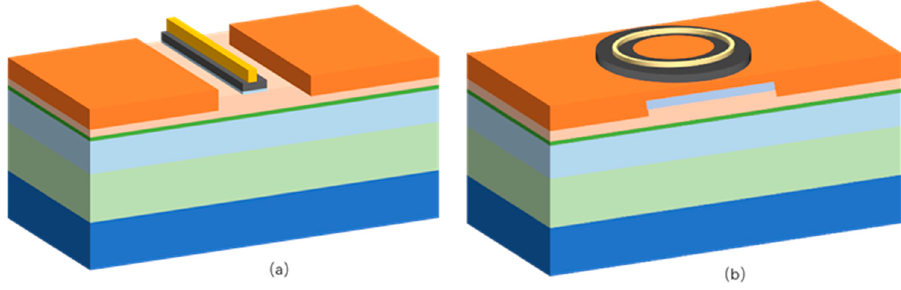
Figure 2. ( a ) 3D image of conventional HEMT device and ( b ) ring-gate HEMT device. Table 1. AlGaN/GaN HEMT devices grouping with different electrode structure and etching depth.